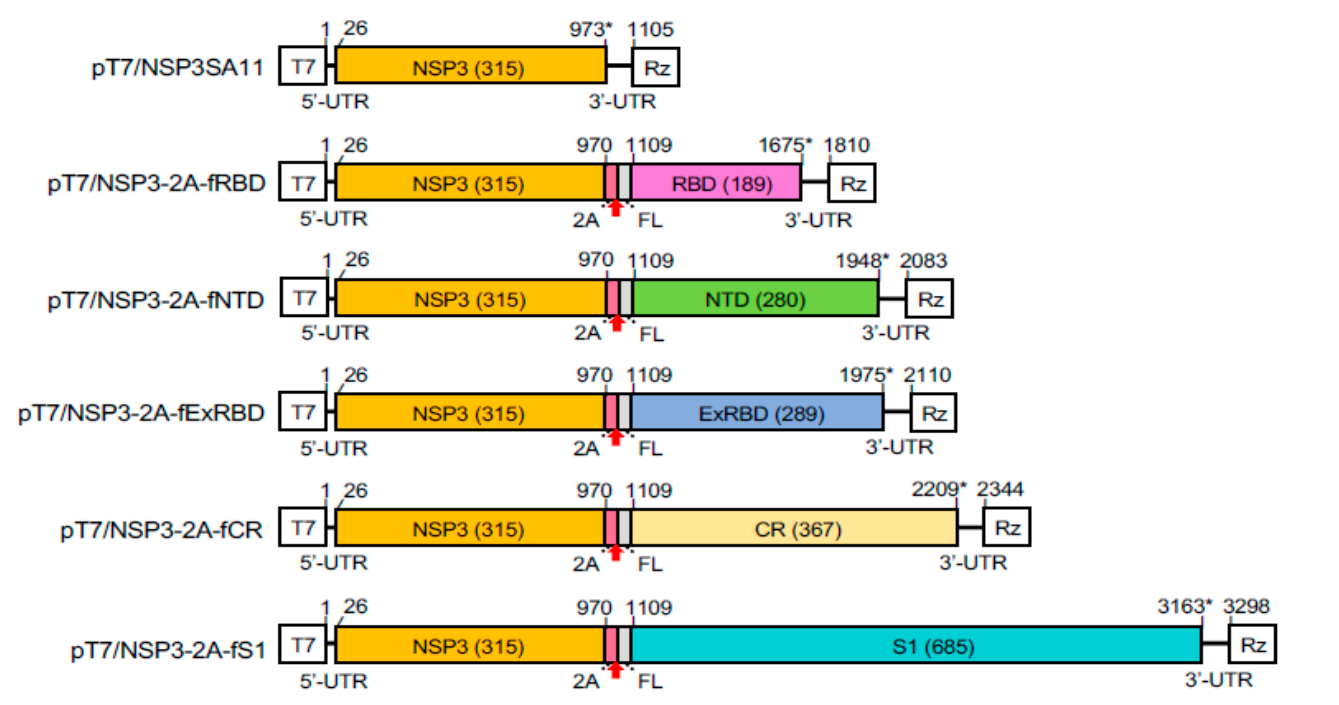
Figure 2. Plasmids with modified segment 7 (NSP3) cDNAs used to generate rSA11 viruses expressing regions of the SARS-CoV-2 S protein. Illustration indicates nucleotide positions of the coding sequences for NSP3, porcine teschovirus 2A element, 3xFLAG (FL), and the complete S1 or portions of the S1 (NTD, ExRBD, and RBD) and S2 (CR) proteins. The red arrow notes the position of the 2A translational stop-restart site, and the asterisk (*) notes the end of the ORF. Sizes (aa) of encoded NSP3 and S products are in parenthesis. T7 (T7 RNA polymerase promoter sequence), Rz (Hepatitis D virus ribozyme), and UTR (untranslated region).